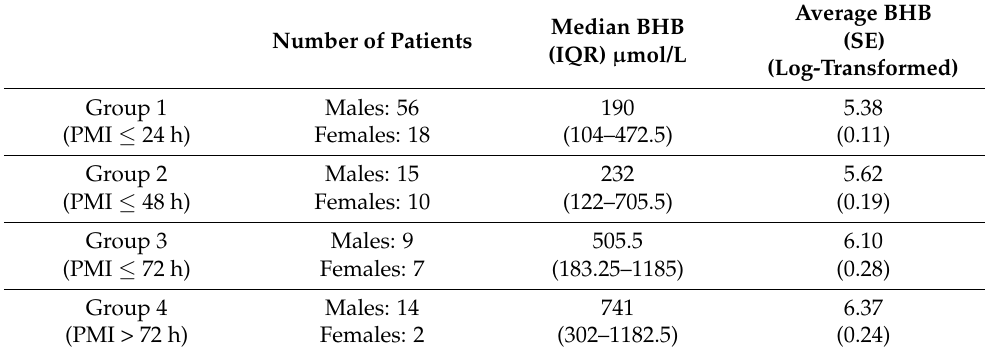
Table 1. Characteristics of each